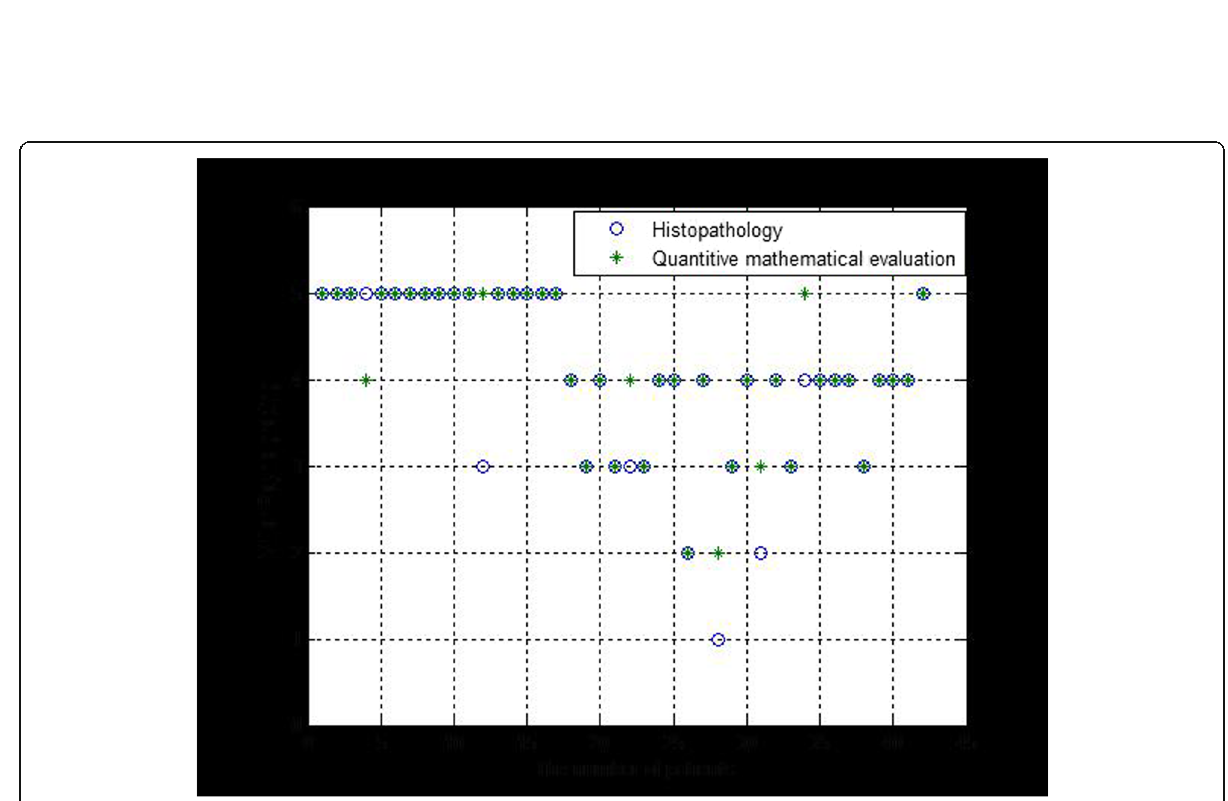
Fig. 4 The correlation between the quantitative mathematical evaluation and the corresponding Miller – Payne